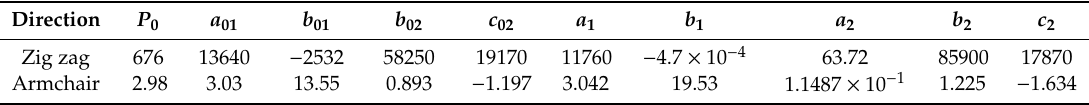
Table 1. Fitting parameters of Equation (1) for the prediction of Young’s modulus variation in TPa.